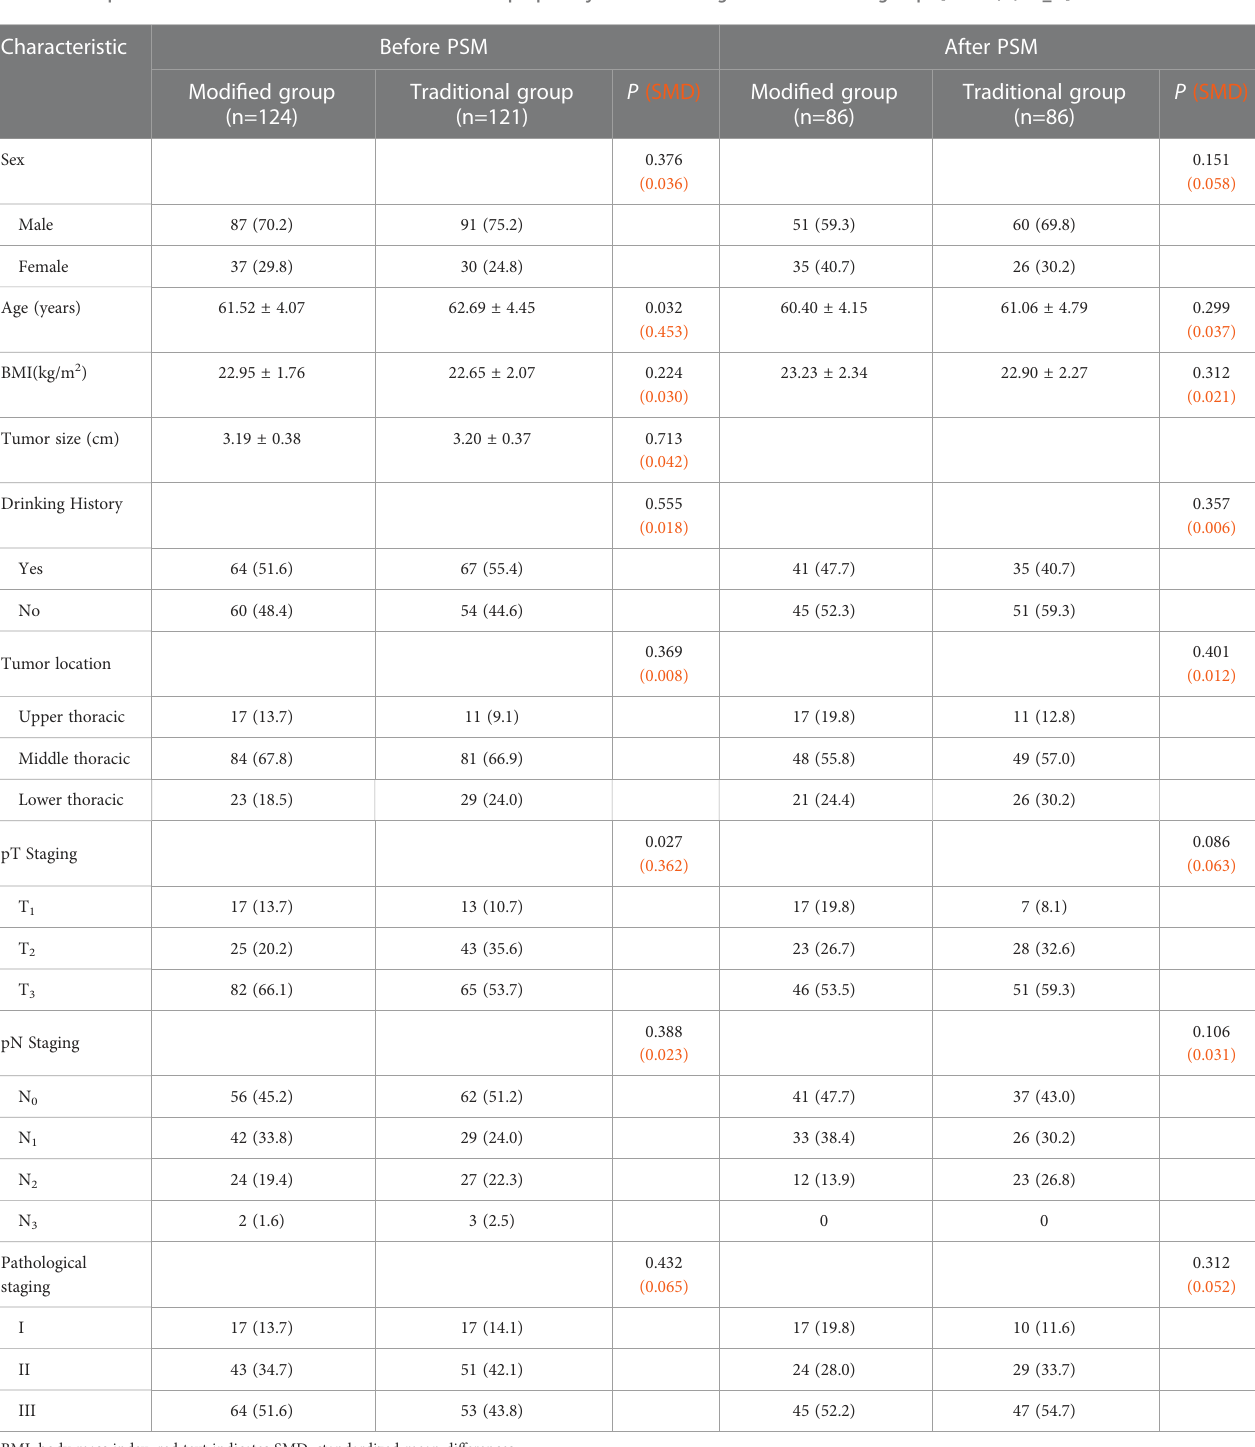
BMI, body mass index; red text indicates SMD, standardized mean